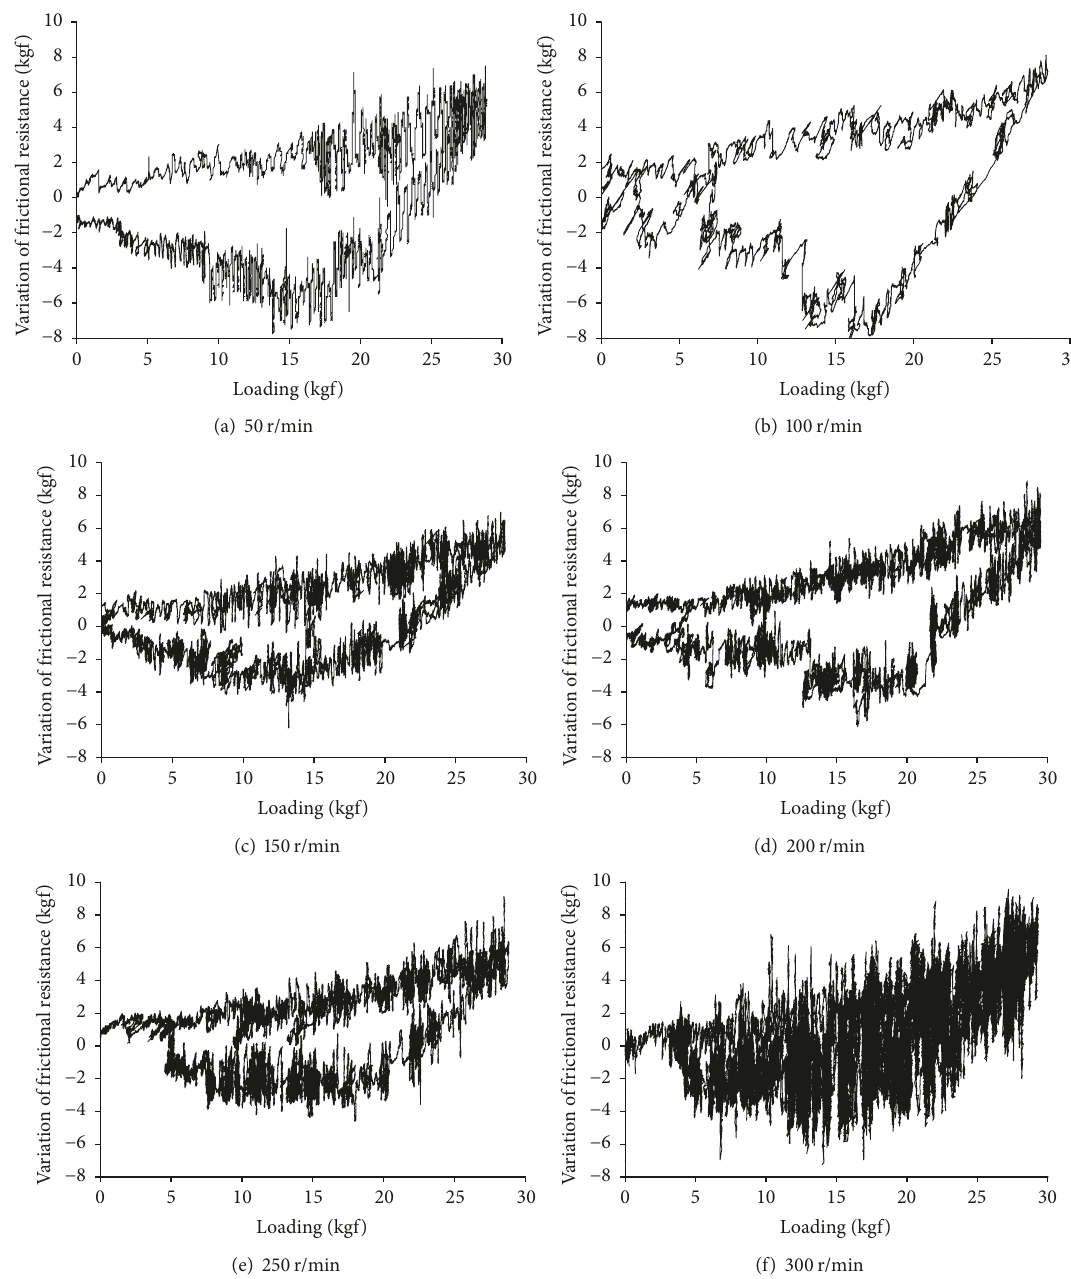
Figure 10: Friction curve with different speeds